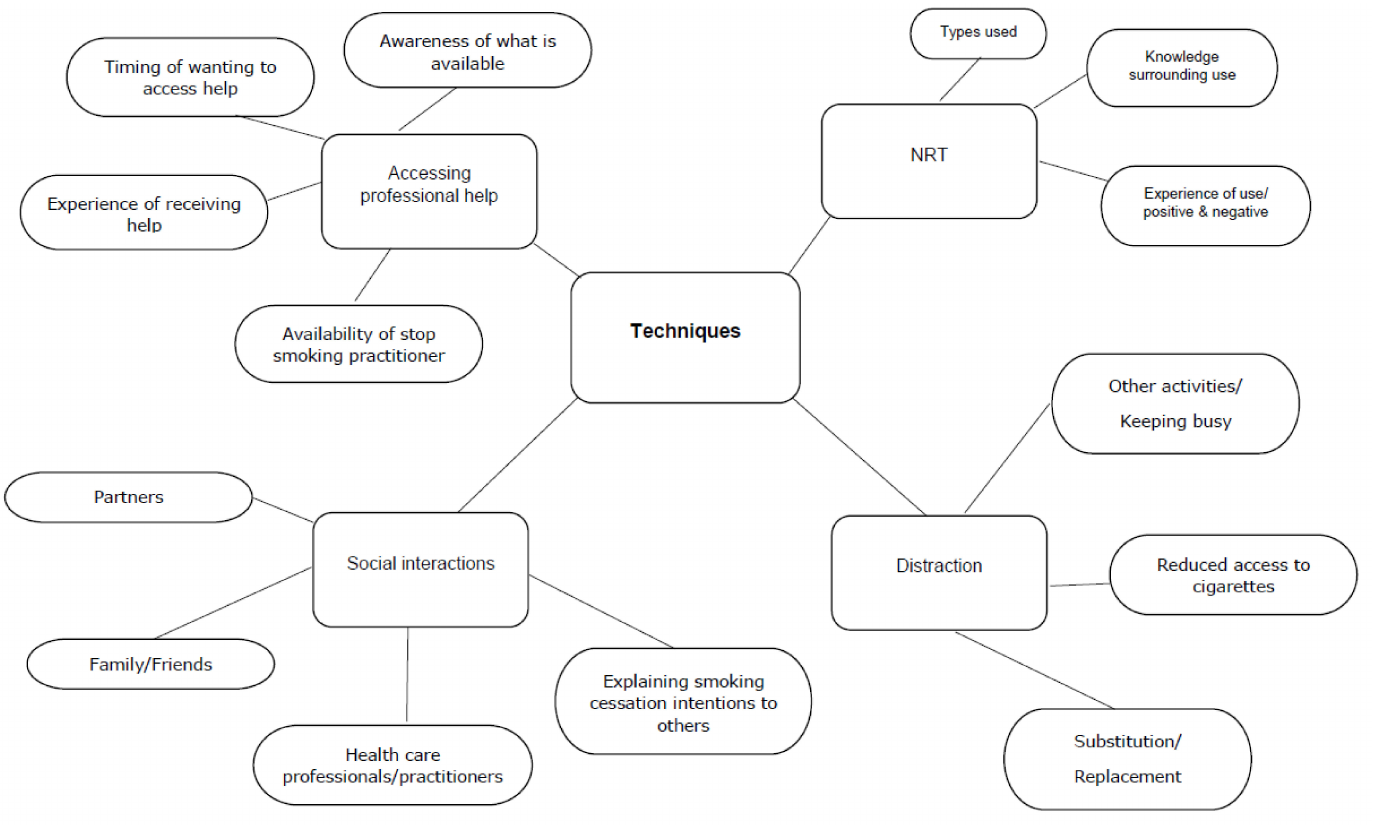
Figure 1. Themes, sub-themes from the analysis of suggestions for techniques that could support